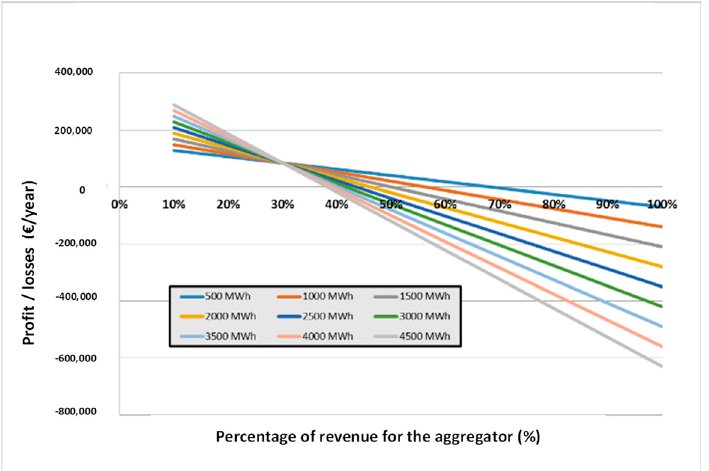
Figure 12. Profit/losses diagram of UVAM users, for a value of the energy sale price equal to 200 €/MWh, depending on the aggregator revenue percentage and parameterized according to the energy exchanged annually with the TSO. “Upward” flexibility case.